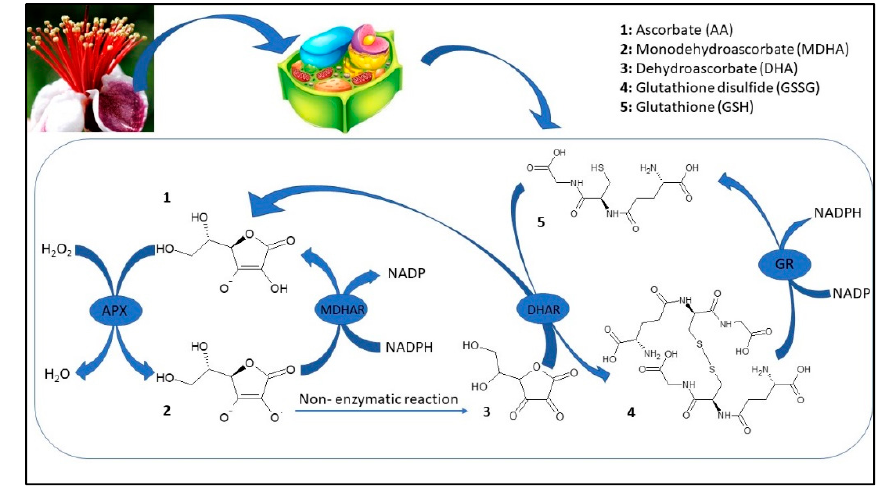
Figure 3. Ascorbic acid-glutathione cycle (APX: Ascorbate peroxidase; MDHAR: Monodehydroascorbate reductase; DHAR: Dehydroascorbate reductase; GR: Glutathione reductase).